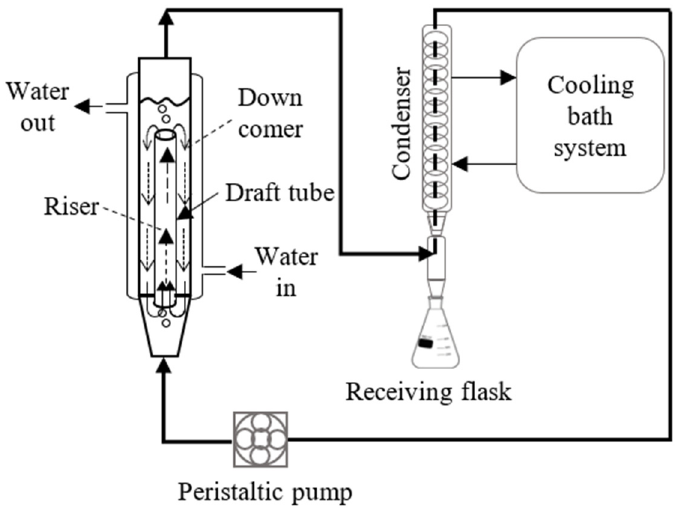
Figure 2. Configuration of an internal loop gas-lift bioreactor integrated with a gas stripping system for butanol production.